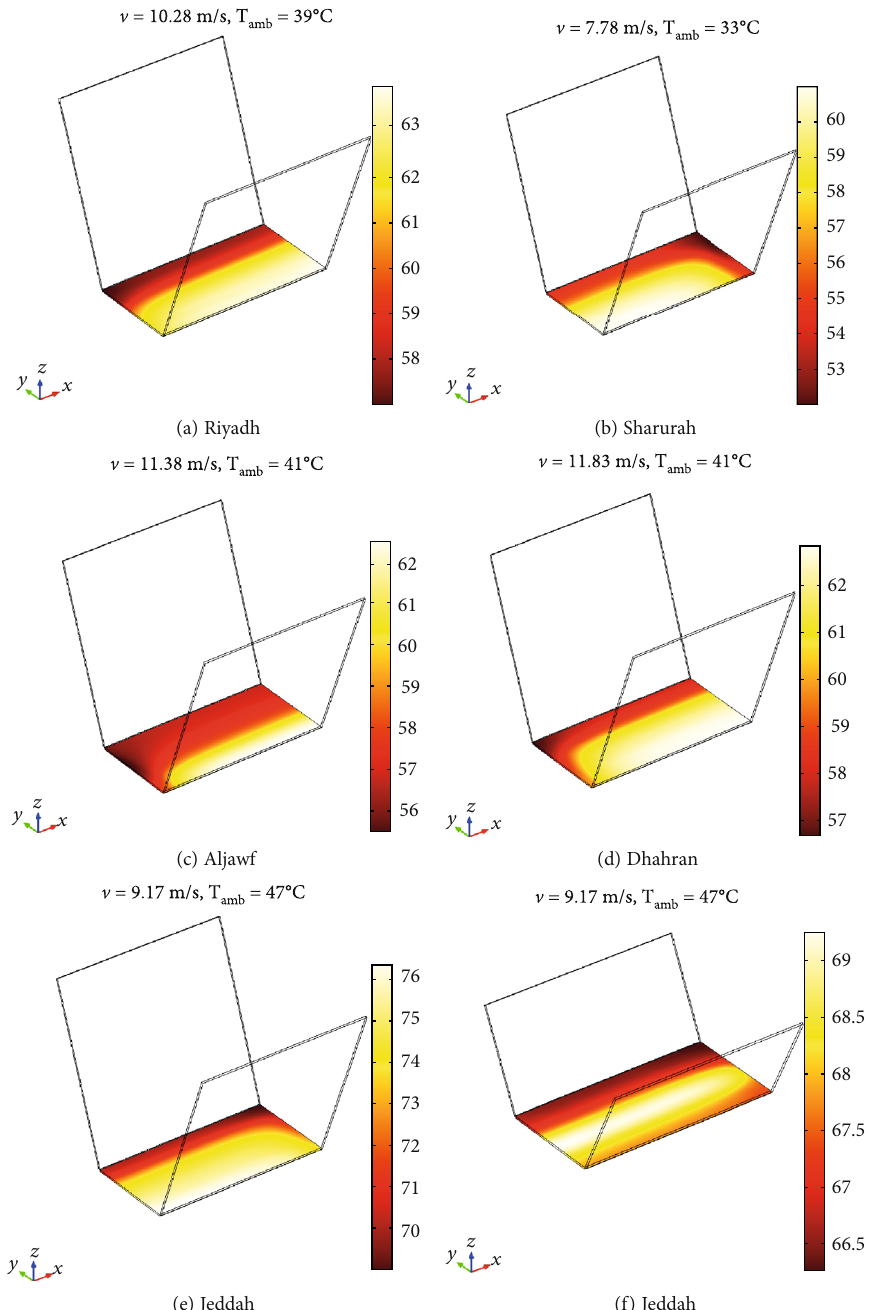
Figure 3: Temperature distribution of a V-trough at noon for (a – e) double coverage and (f) partial